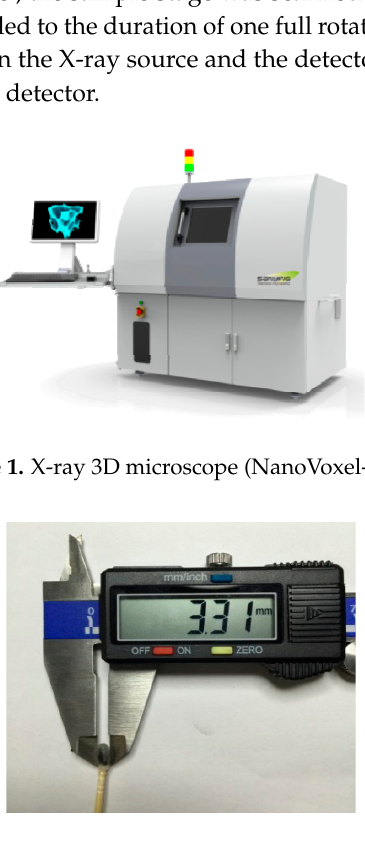
Figure 2. Diameter measurement of the ore core. Table 1. Setting of scanning parameters of X-ray 3D microscope.